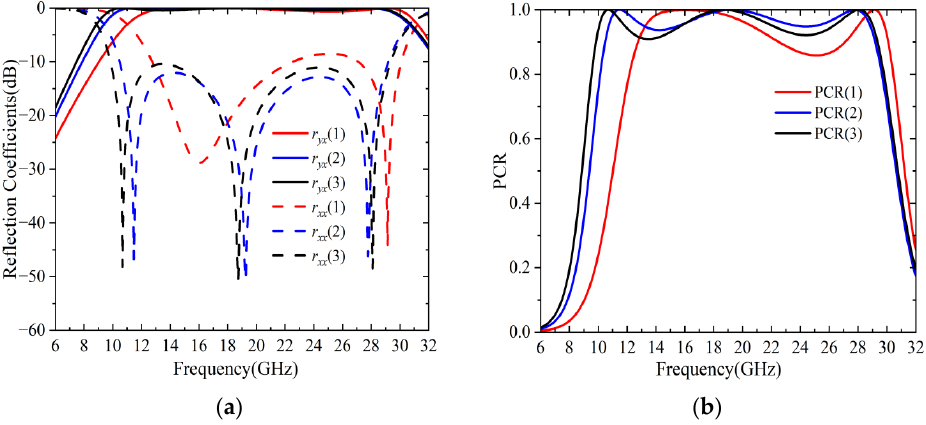
Figure 4. Simulation results for unit cells. ( a ) Reflective coefficients; ( b ) PCRs.